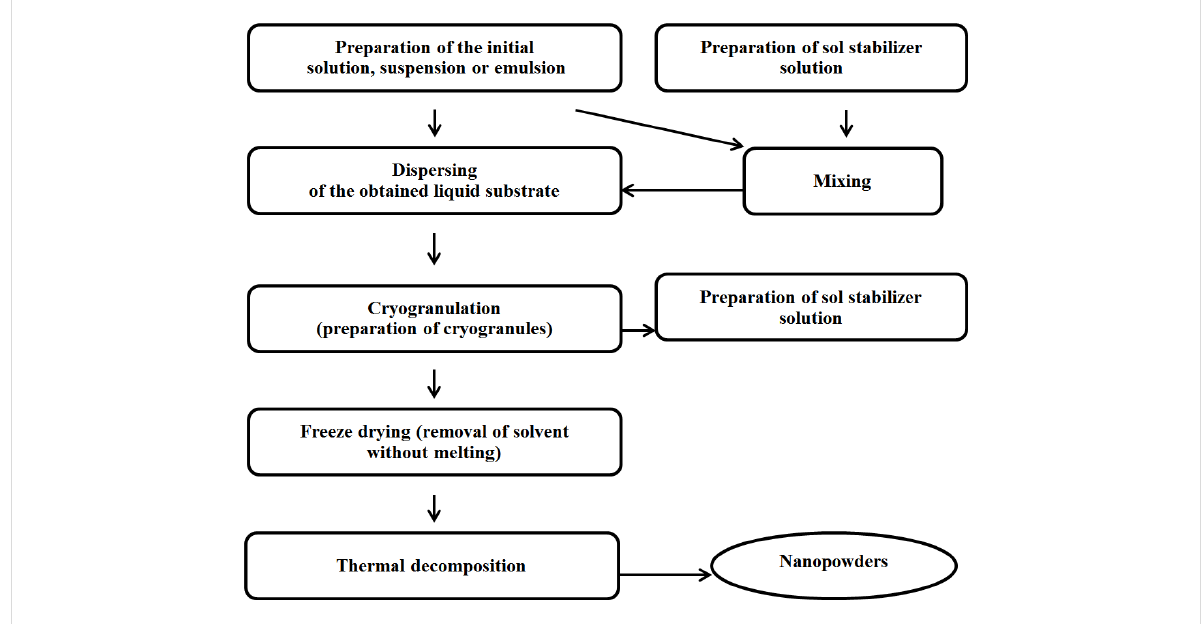
Figure 1: Steps of the cryochemical synthesis of